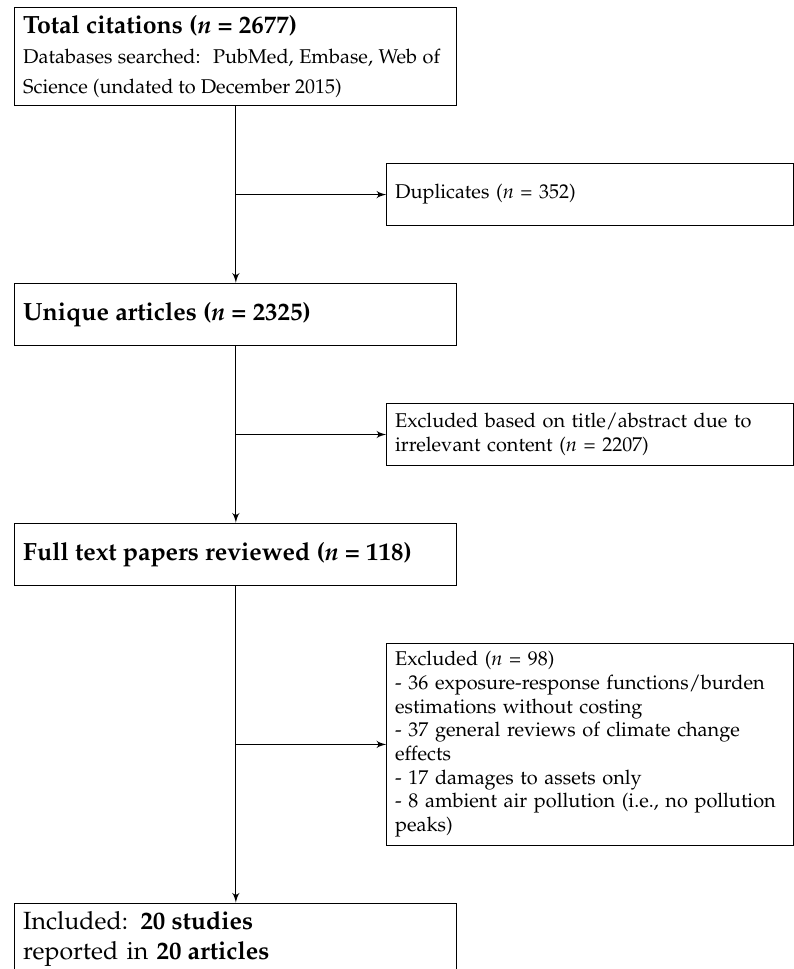
Figure 1. Flow chart of document